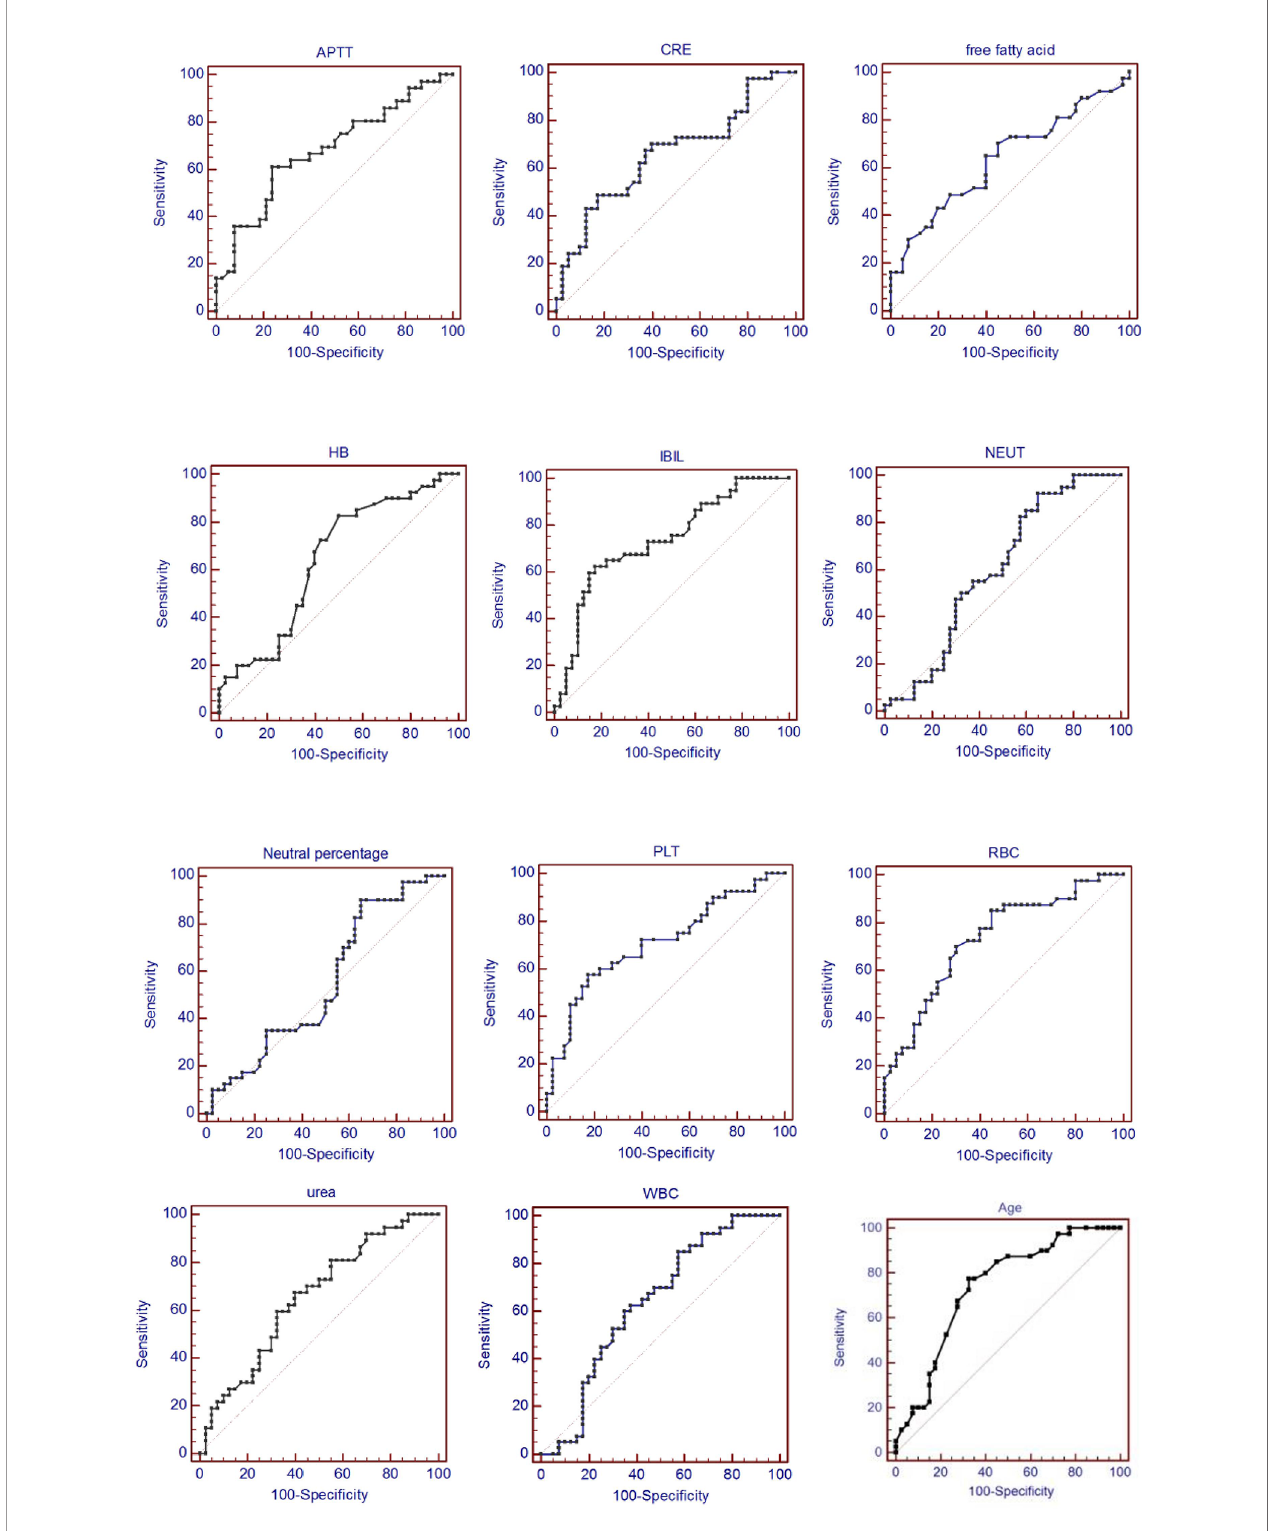
FIGURE 1 | ROC curve of each test